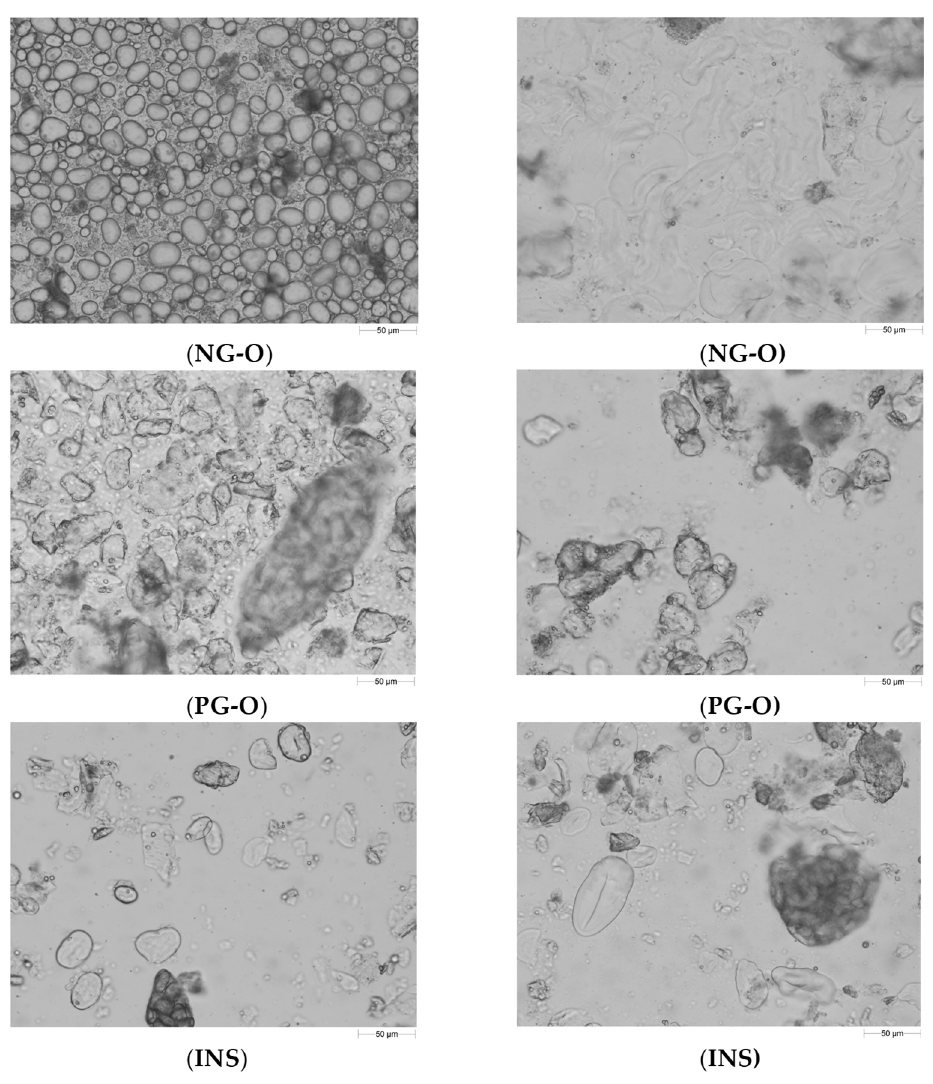
Figure 2. Micrographs showing the microstructure of suspensions of potato starch (PS), non-gelatinised open cell chickpea flour (NG-O), pre-gelatinised open cell chickpea flour (PG-O), and commercial pre-gelatinised chickpea flour (INS) dispersed in cold (20 °C) and boiling (100 °C) water (Magnification 20x. Scale bar: 50 μ m).